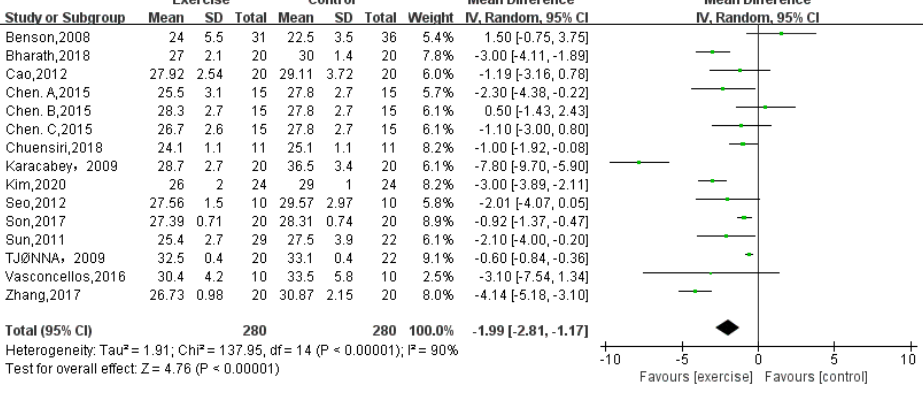
Figure 3. Forest plot of BMI.